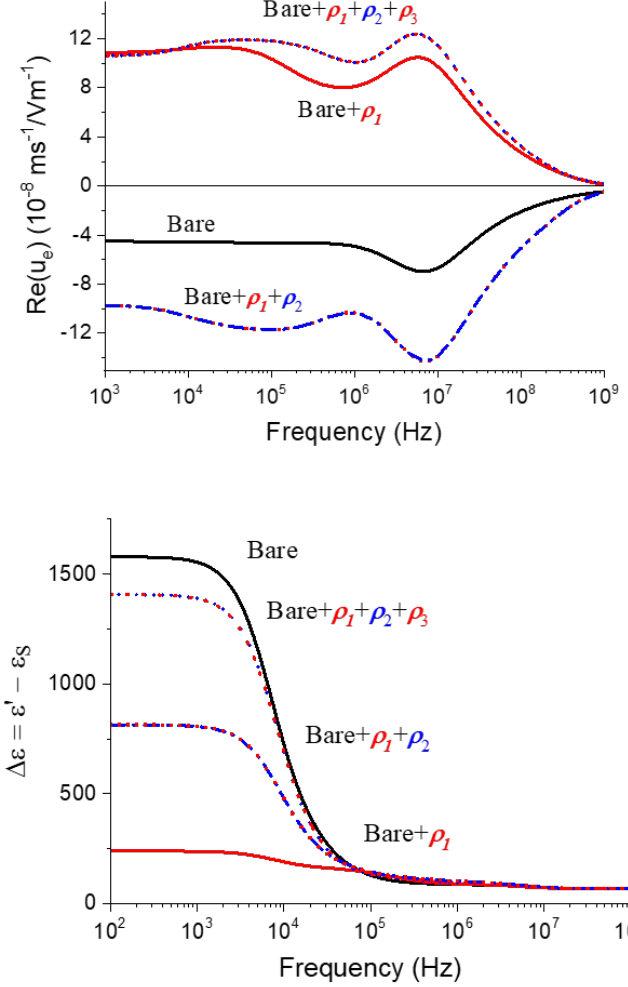
Figure 7. Theoretical predictions of the real part of the dynamic mobility (top) and dielectric dispersion (bottom) for 2% suspensions of latex particles with the coatings indicated. The core particle is a 1000 nm diameter polystyrene particle with − 10 µ C/cm 2 surface charge. All coatings are 40 nm thick, and their volume charges are as follows (in C / m 3 ): ρ 1 = + 7 × 10 5 , ρ 2 = − 7 × 10 5 , ρ 3 = + 7 × 10 5 .